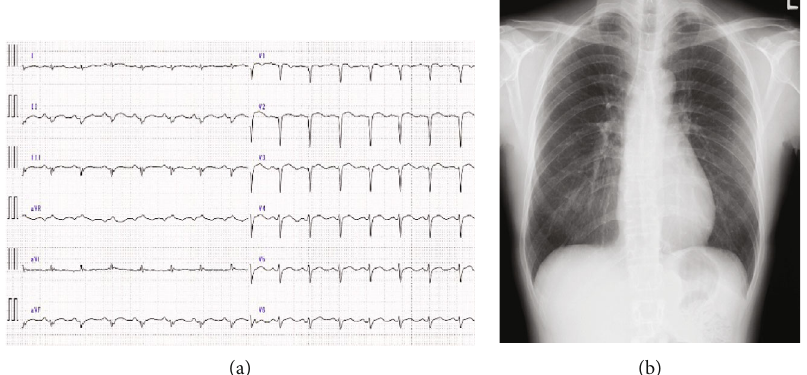
Figure 1: Electrocardiography and thoracic radiography fi ndings on admission. (a) Electrocardiogram shows a sinus rhythm with poor R progression in precordial leads; (b) postero-anterior thoracic radiogram shows no features of heart